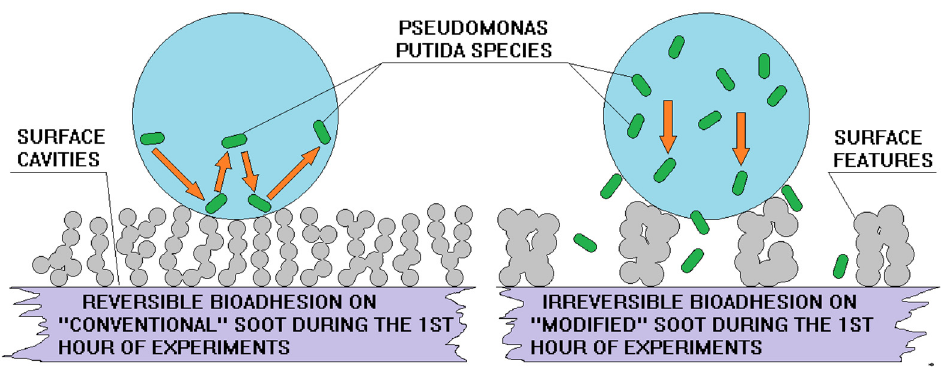
Figure 6. Reversible ( left part ) and irreversible ( right part ) bioadhesion on super-nonwettable carbon soot coatings. Reproduced with permission from [24]. Copyright 2020 Elsevier.